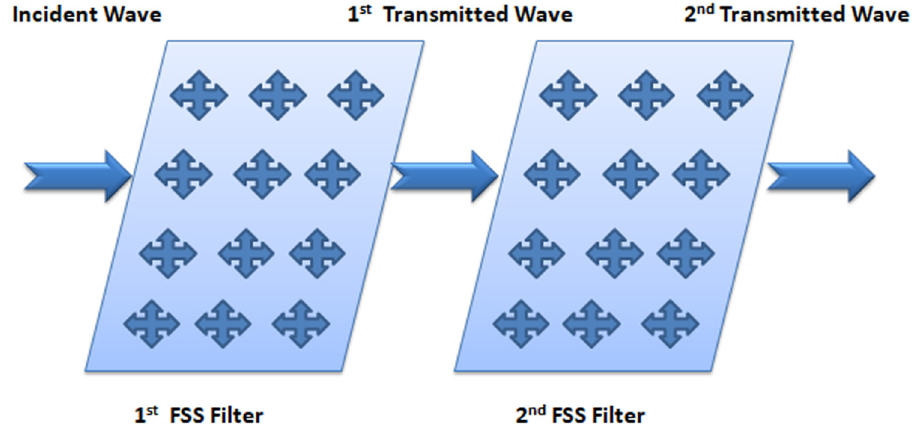
Figure 1: Illustration of the working of FSS layers based on di ff erent element